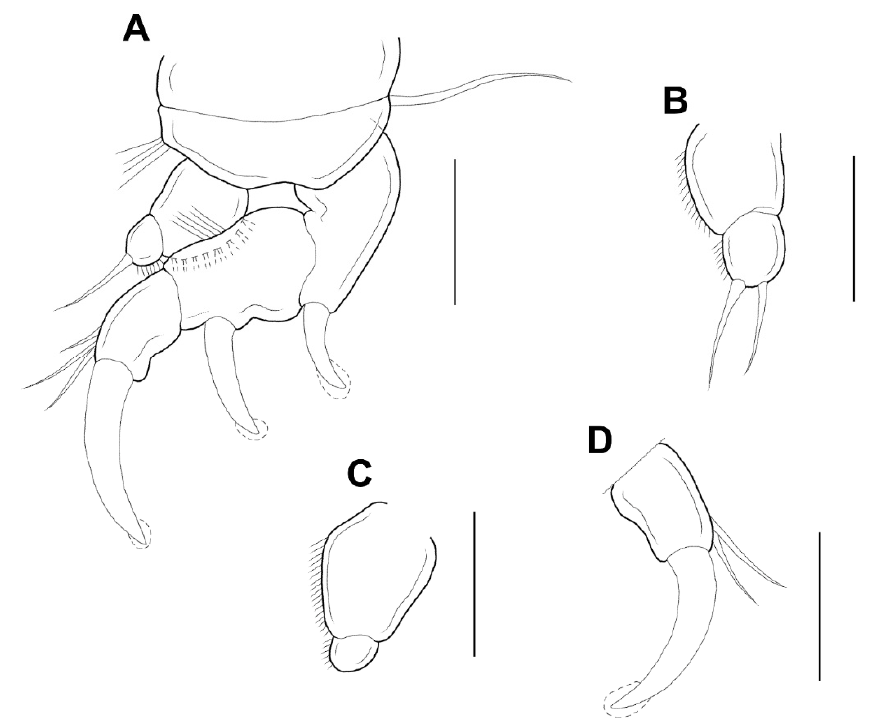
Figure 5. Xarifia yanliaoensis sp. nov. female. leg 1 ( A ); endopod of leg 2 ( B ); endopod of leg 3 ( C ); terminal segment of exopod of leg 3 ( D ). Scale bars: ( A – D ) = 0.025 mm. Leg 5 (Figure 3A–C) 155.4 µm long, 44.4 µm wide at base, tapering distally, armed with single proximal seta and 2 apical setae. Male: Body (Figure 6A,B) slender than female, about 8.6 times longer than wide. Length 1.38 (1.23–1.52) mm and greatest width 0.16 (0.15–0.16) mm based on two speci- mens in lactic acid before dissection. Caudal ramus (Figure 6C) small, about 25.0 × 19.1 µm, as in female, bearing 5 setae. Body surface smooth.